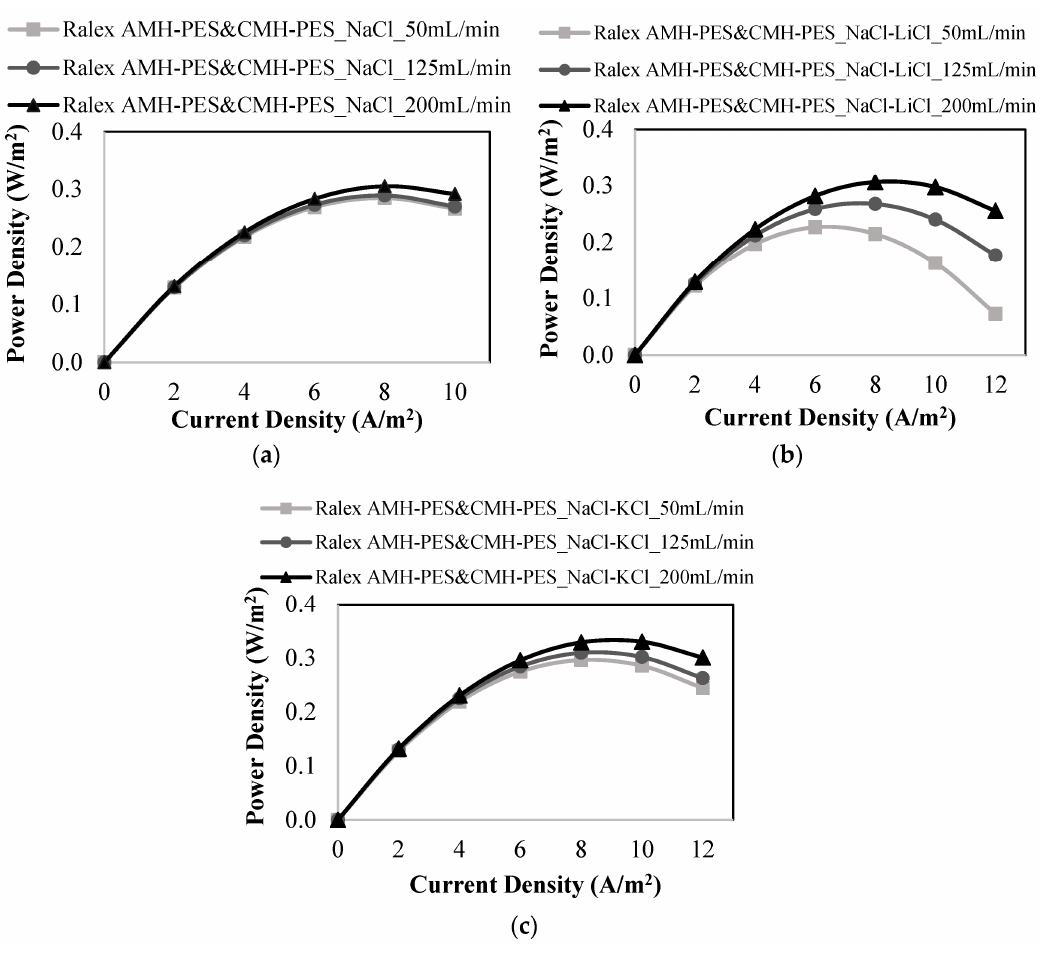
Figure 4. Power density vs. current density plots at different feed flow rates for the studies per- formed with ( a ) only NaCl, ( b ) a mixture of NaCl and LiCl, ( c ) a mixture of NaCl and KCl using Ralex AMH-PES & CMH-PES membranes.